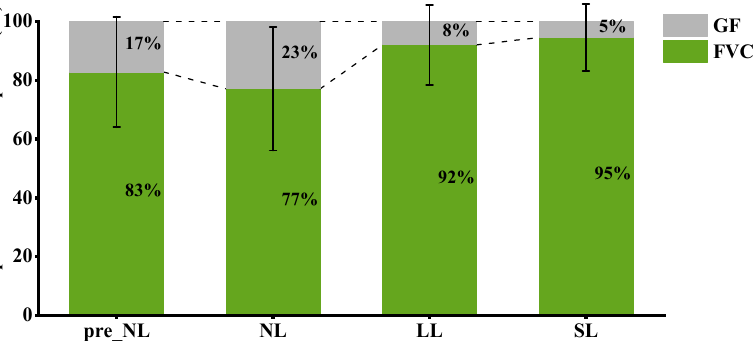
Figure 7. Changes of vegetation coverage in sample plots. Pre_NL is the result before lodging, the three on the right are the results of different levels after lodging, the green part is the green-leaf fraction, and the gray part is the gap fraction.